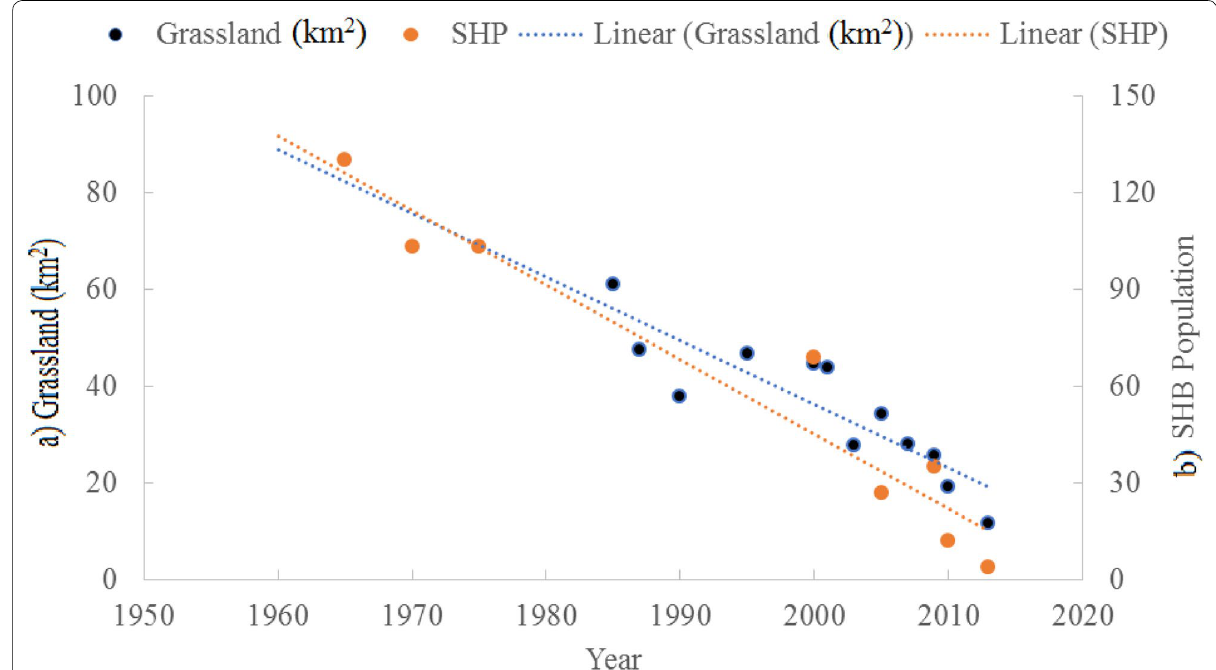
Fig. 6 Trends on the spatial extent of grassland (GL) habitat and Swayne’s hartebeest (SHB) population in